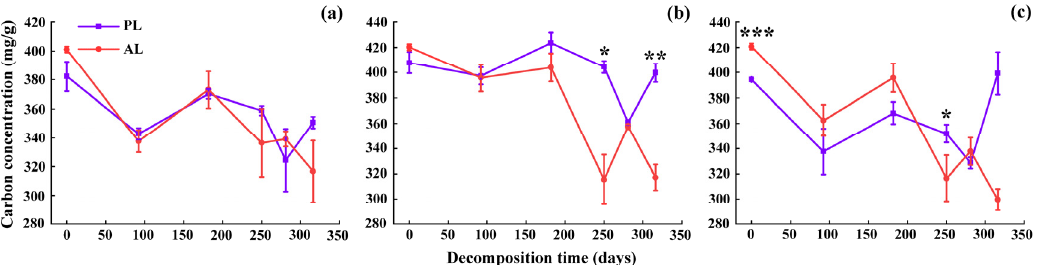
Figure 4. The carbon concentration dynamics of goldenrain tree ( a ), camphor tree ( b ), and weeping willow tree ( c ) foliar litter in the urban forest. PL and AL indicate physiological and abnormal litter, respectively. * p < 0.05, ** p < 0.01, *** p < 0.001.